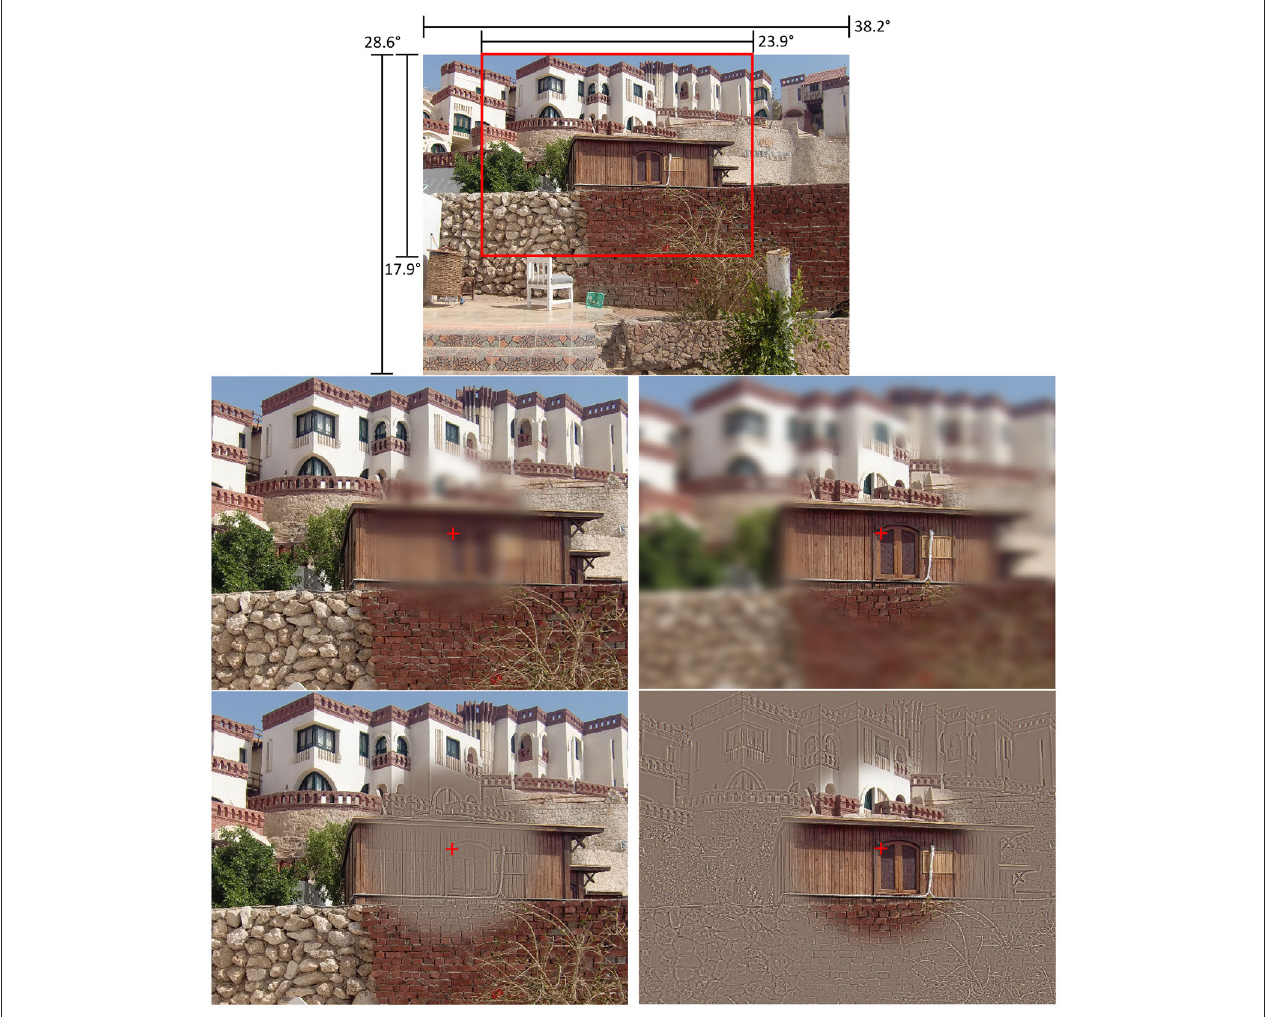
FIGURE 2 | Illustration of the five filter conditions. The red cross indicates the current gaze position. The top panel shows the original stimulus from the scene memorization task in the unfiltered control condition. Below, the four filter conditions are illustrated with cropped and zoomed-in versions of the original stimulus (indicated by the red frame) to better illustrate the filter effects. (Middle row, left) Central low-pass filter. (Middle row, right) Peripheral low-pass filter. (Bottom row, left) Central high-pass filter. (Bottom row, right) Peripheral high-pass